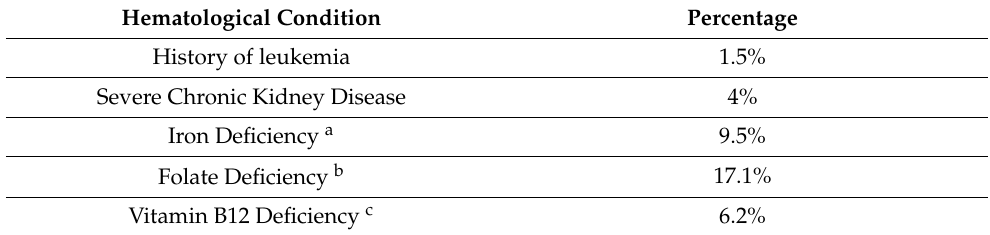
Table 2. Hematological Conditions.